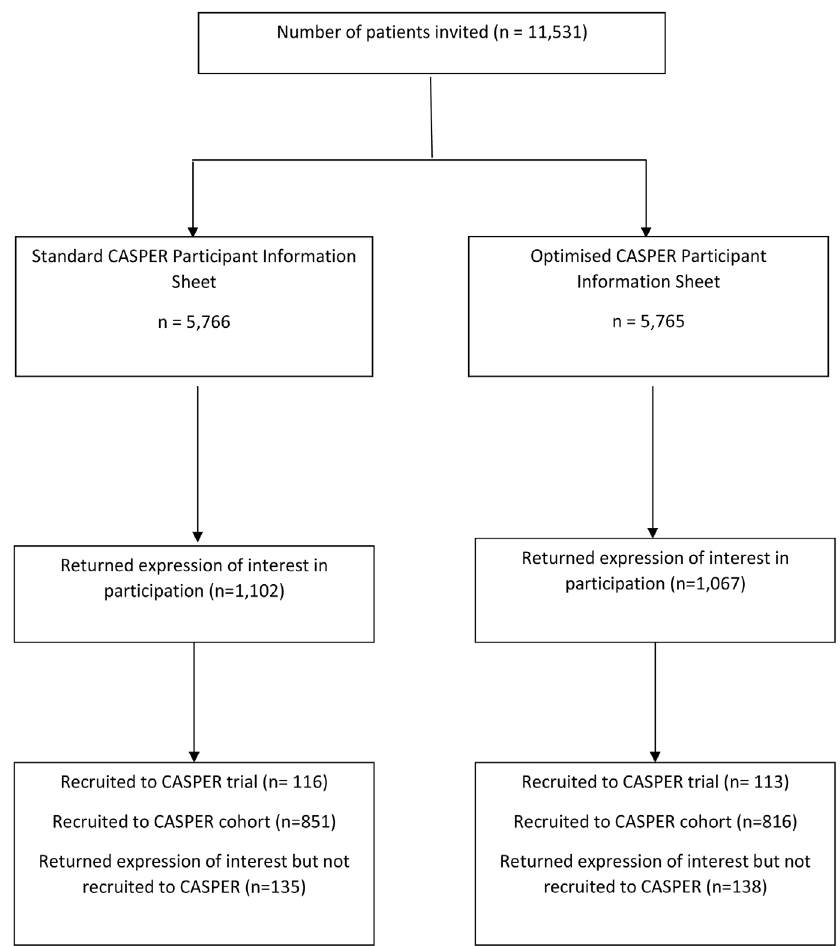
Figure 1. Flow diagram of recruitment to the CASPER